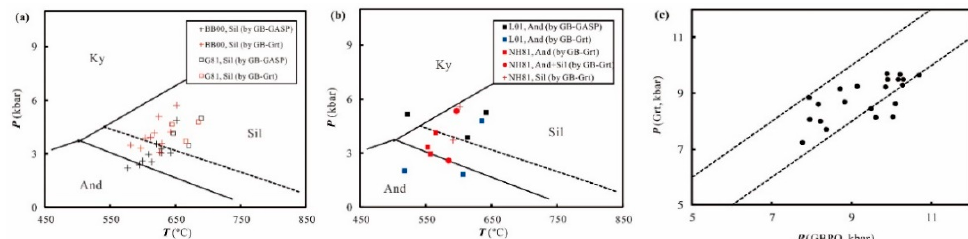
Figure 4. Application of the present garnet geobarometer to natural metapelite samples (Table S2) not included in the calibration. To simultaneously obtain P–T conditions, the garnet-biotite geothermometer [55] was combined with either the present garnet, or the GASP [49] or the GBPQ [50] geobarometers. ( a ) Sillimanite-bearing metapelite in the mafic complex contact aureole, Ivrea Zone, Northern Italy (BB00; [68]), and sillimanite-bearing metapelite at the Molodezhnaya Station, eastern Antarctica (G81; [69]); ( b ) Andalusite-bearing metapelite in the contact aureole in the Transangarian region of the Yenisei Ridge, eastern Siberia, Russia (L01; [70]), and andalusite- or sillimanite-bearing metapelite in the Augusta quadrangle, south-central Maine (NH81; [71]); and ( c ) Comparison of the present garnet and the GBPQ [50] geobarometers to Al 2 SiO 5 -free metapelite in the Furulund Group,